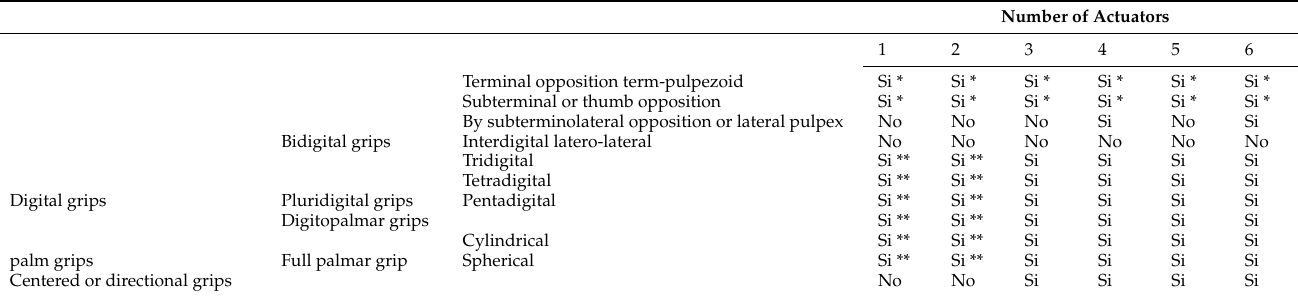
Table 5. Feasible grips based on the number of actuators in a hand prosthesis.